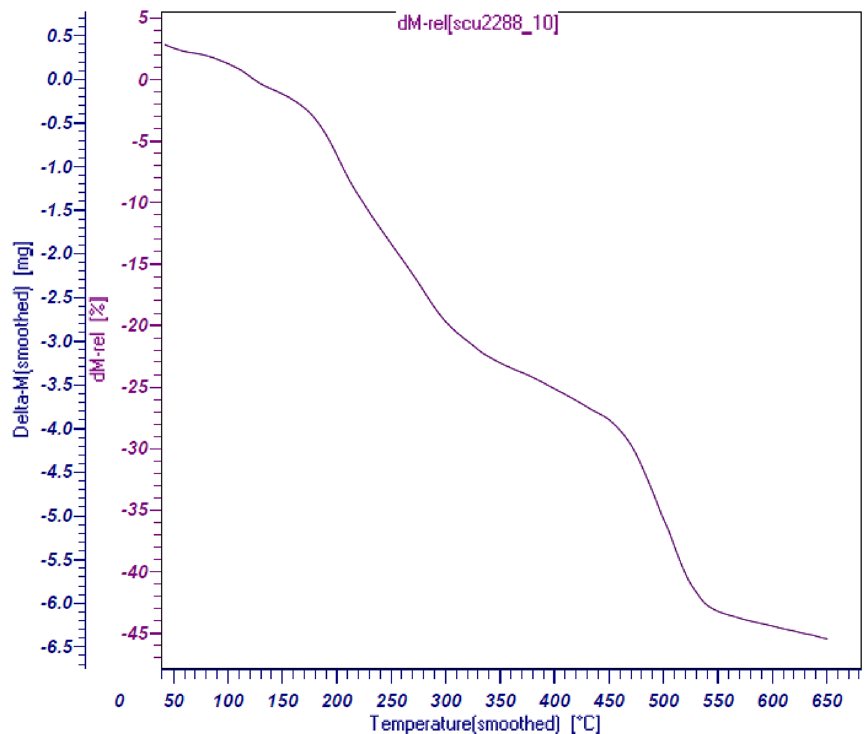
Figure 8. Thermo-gravimetric analysis of the SSE@GO-CuFe 2 O 4 nanocomposite.